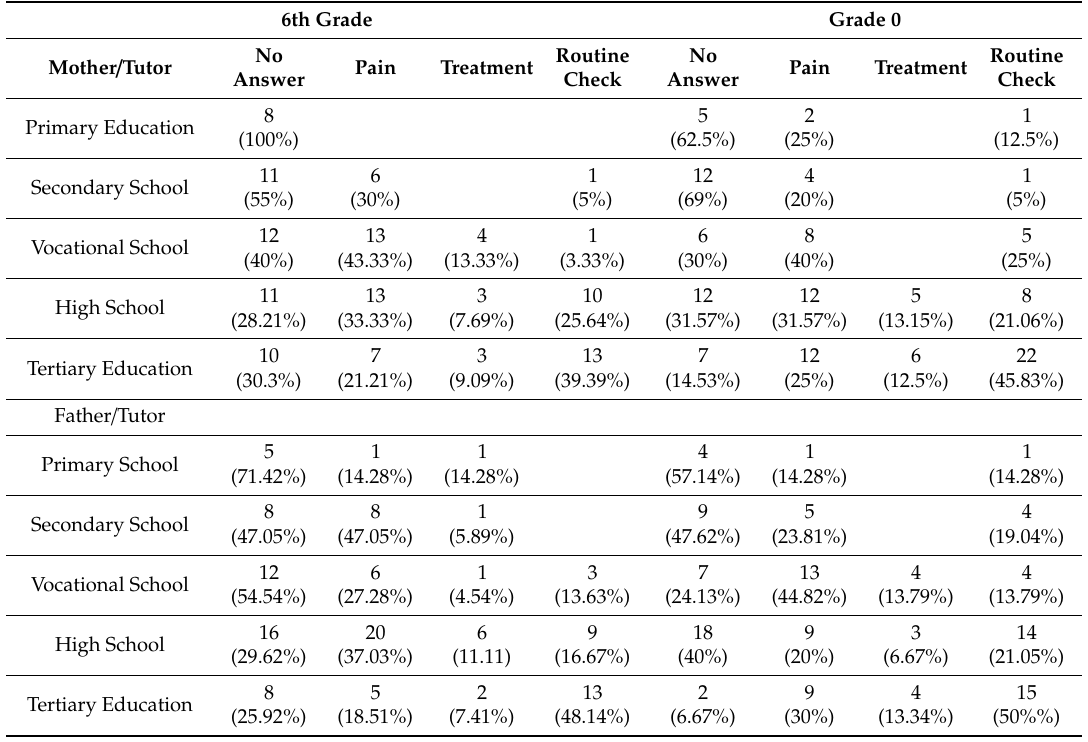
Table 4. Correlation between parents’ education and reason for a dental visit in 12 and 6-year-old